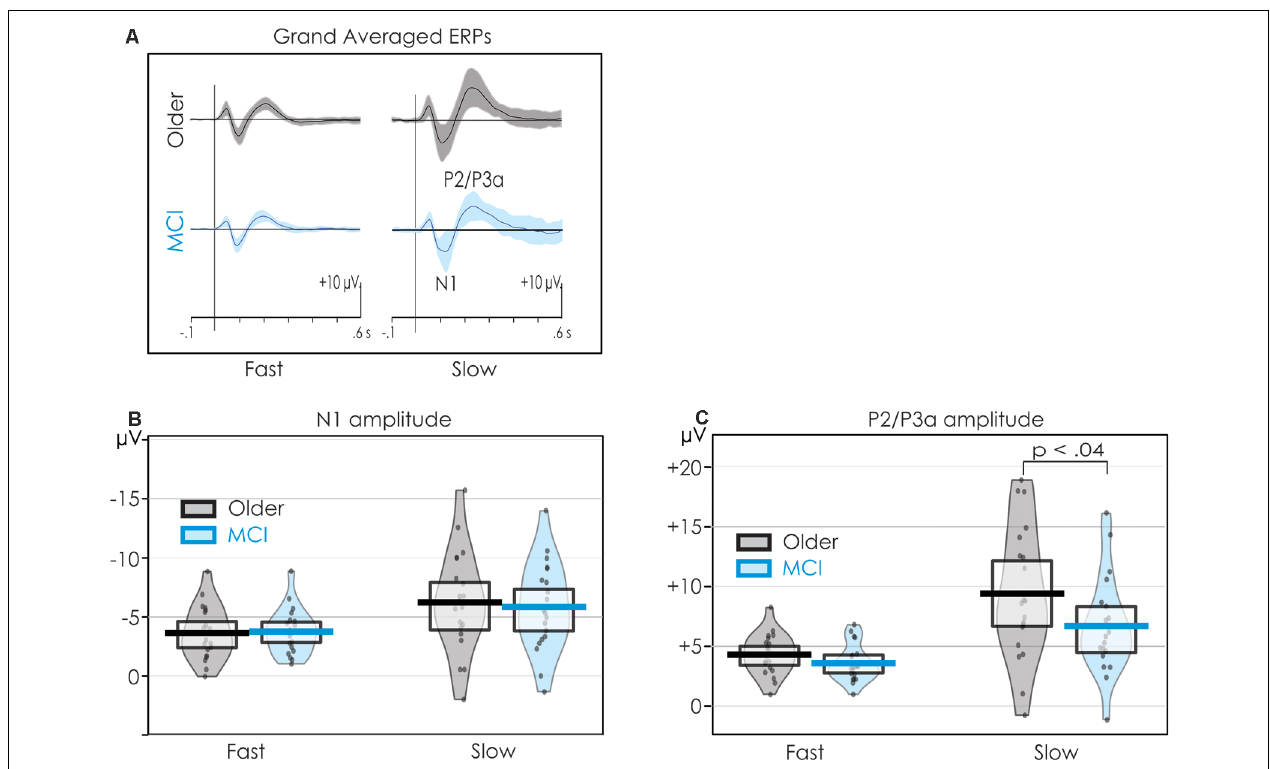
FIGURE 3 | Pirateplots of N1 and P2 data providing both descriptive and inferential statistics. Data are collapsed across all central electrode (C3, Cz, C4) sites. The grand averages and SDs (shaded) are illustrated in panel (A) . The mean amplitudes of N1 and P2 (thick, solid horizontal line), 95% confidence intervals (CIs; light horizontal box), smooth frequency distribution (shaded area), and individual data points (jittered) are presented in panels (B,C) respectively. The mean amplitude of N1 did not differ between the groups in the fast condition. On the other hand, P2 was larger for the healthy older adults when stimuli were presented slowly.